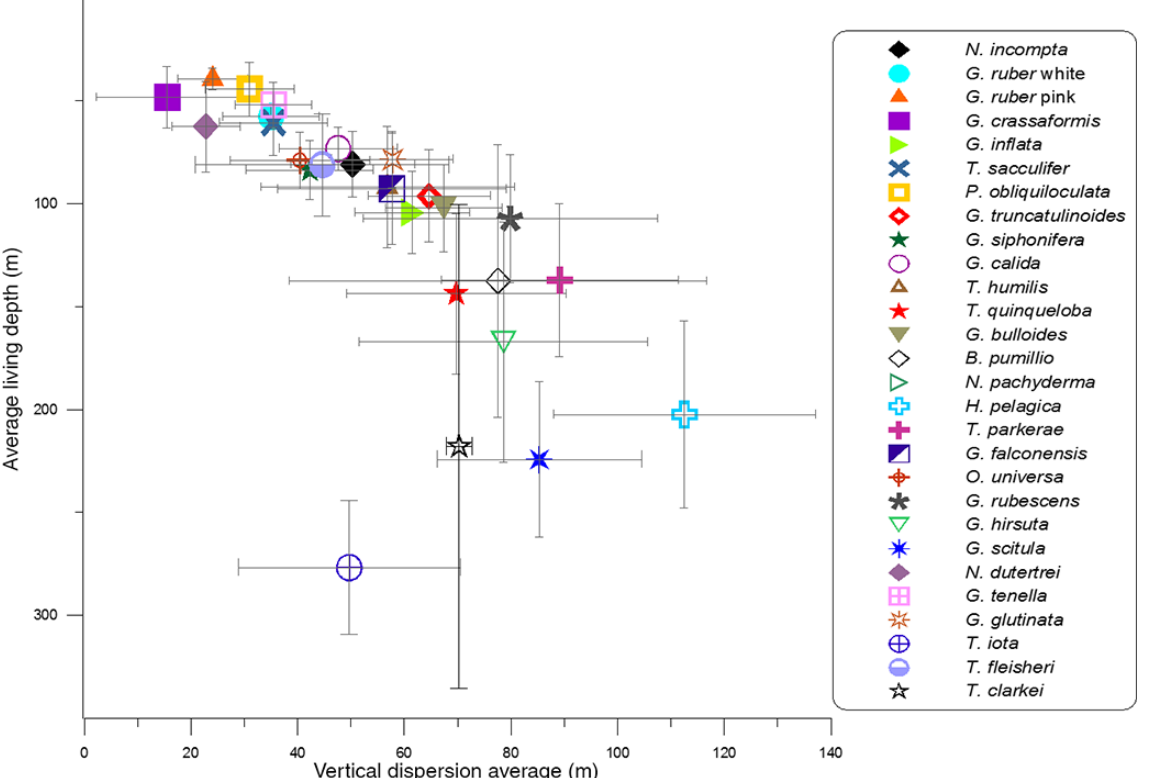
Figure 8. Relationship between the mean ALD and the mean vertical dispersion of the habitat of the 28 most abundant species of planktonic foraminifera analyzed in this study. Symbols are showing mean values, bars indicate 95% confidence intervals and colored ellipses are used to highlight species with similar depth preferences (see Fig.